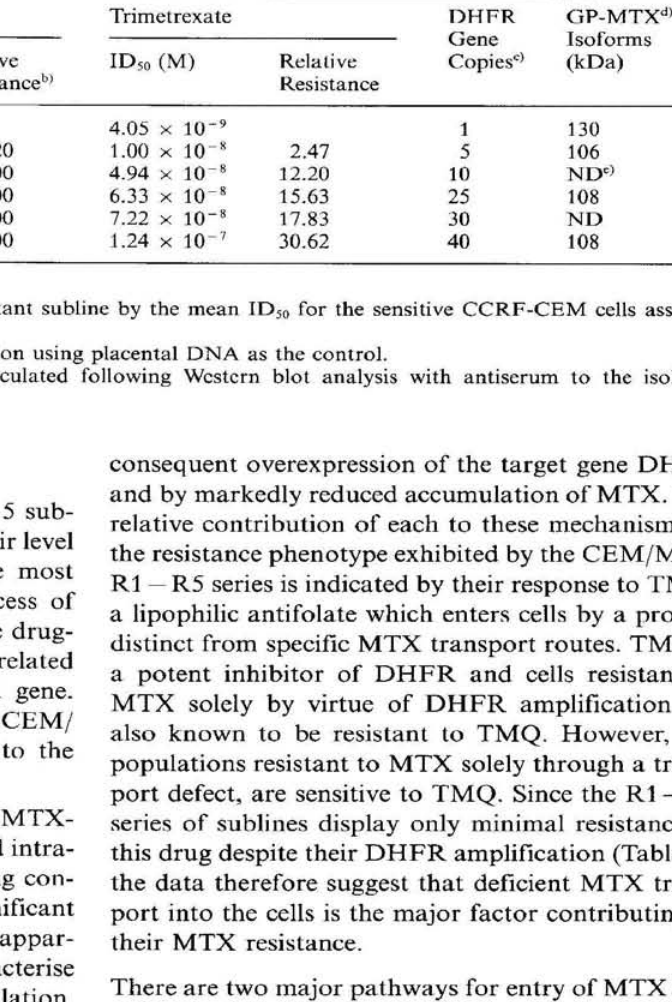
Table 1. Resistance to methotrexate and trimetrexate in CCRF-CEM sublines